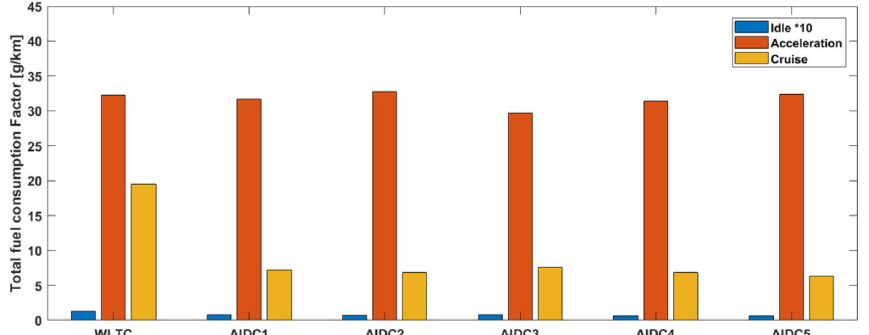
Fig. 11 Total fuel consumption factors for cycles according to driving